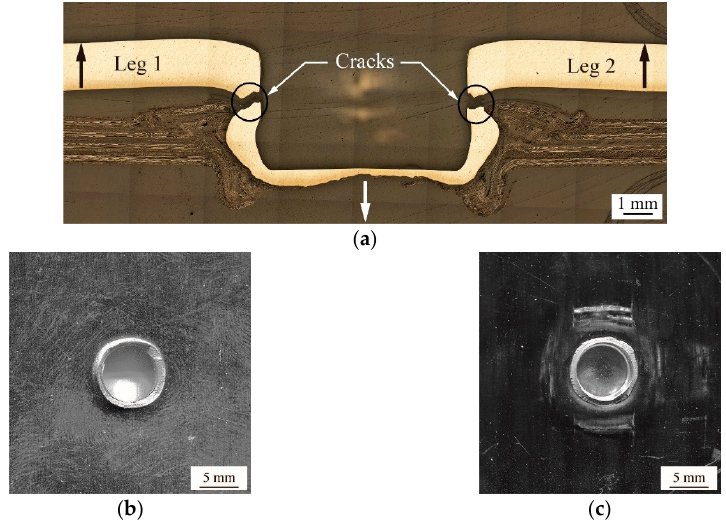
Figure 15. ( a ) A cross-sectional micrograph of a failed clinch joint subjected to cyclic cross-tension loads ( ∆ F = 389 N ). The fatigue life is 23,623 cycles. ( b ) The bottom surface of the upper sheet (AA5052) and ( c ) the top surface of the lower sheet (TP-CFRP) with a failed clinch